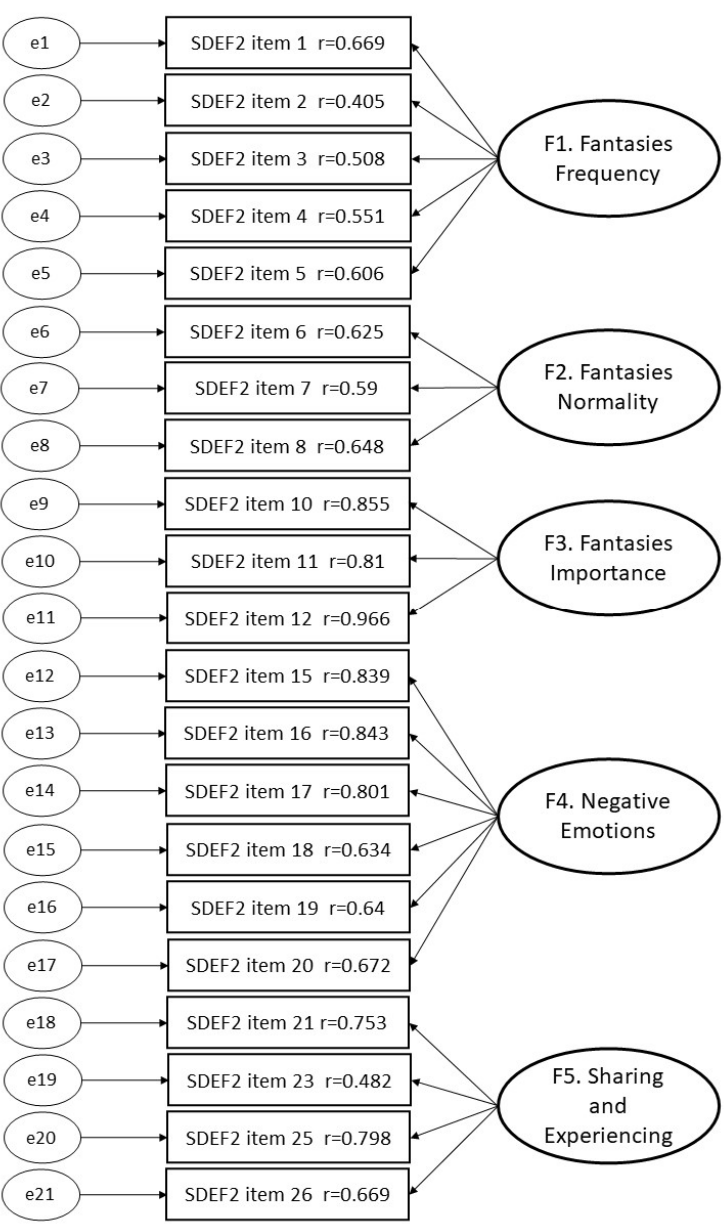
Figure 1. Path diagram of the confirmatory factorial analysis of the SDEF2 (n = 886). CFAs were also run separately for gender (cisgender women and men) and sexual orientation (heterosexual, bisexual, and homosexual) to test the fits in the subgroups.